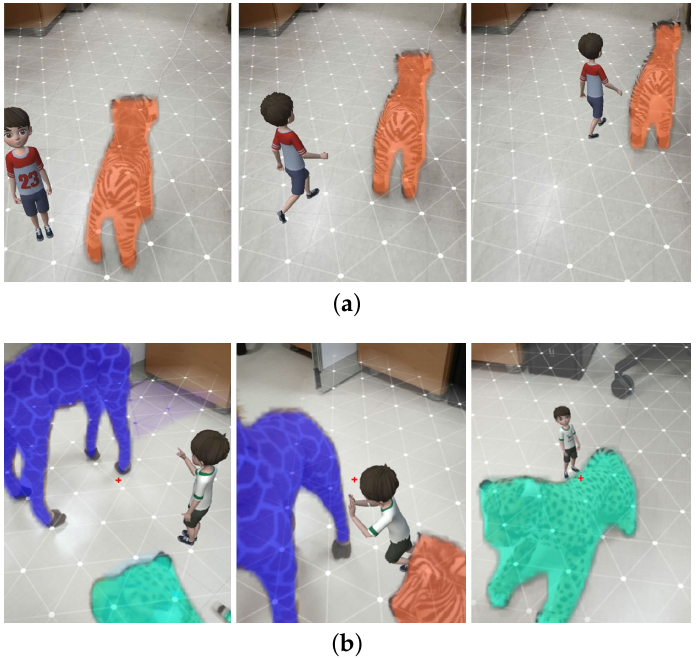
Figure 8. Realistic interactions between a virtual human and real animal dolls by using the silhouette meshes. ( a ) Approaching and following interaction: the virtual human follows the moving zebra doll using the object’s location updated in real-time; ( b ) pointing, pushing, and riding interaction: the virtual human uses the gaze point to select the target object and perform